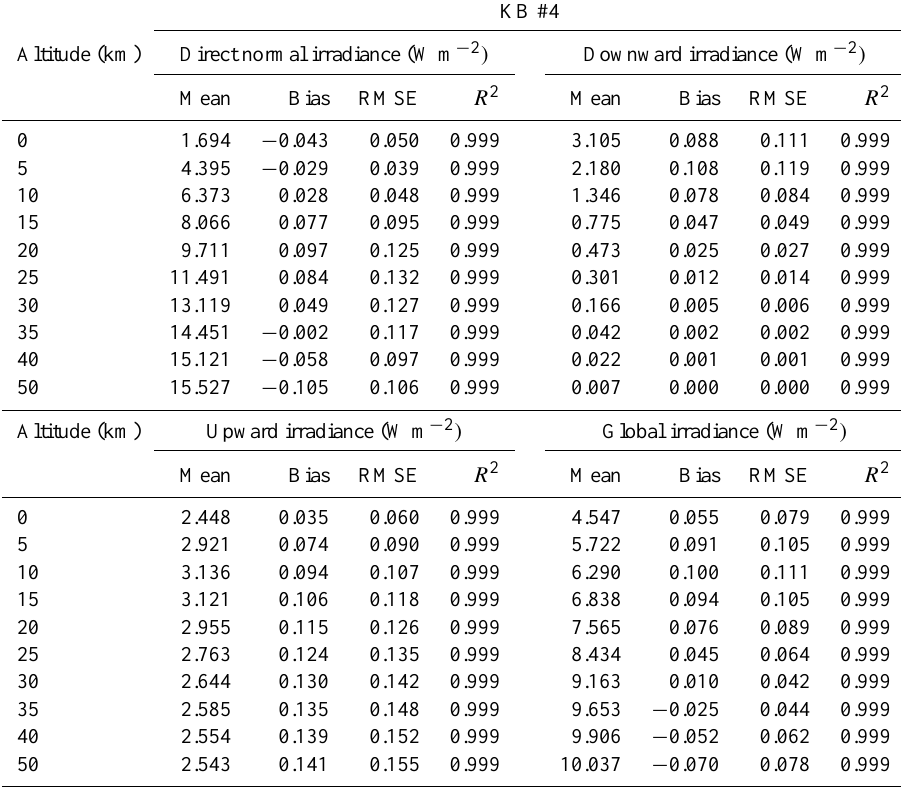
Table 4. Statistical indicators of the performances of the new parameterization for computing the irradiances in Kato band #4 at different altitudes above ground level. Mean is the mean irradiance obtained from the detailed spectral calculations considered as